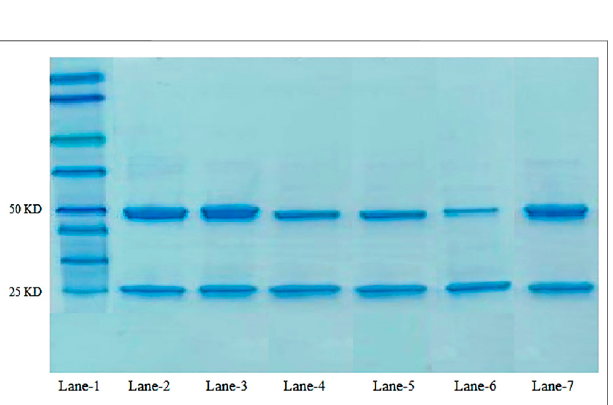
FIGURE 4 | SDS-PAGE of the antibody: lane-1: molecular weight marker; lane 2-3: native antibody trastuzumab; lane-6: PTX 108ab; and lane- 7: PTX 112ab.